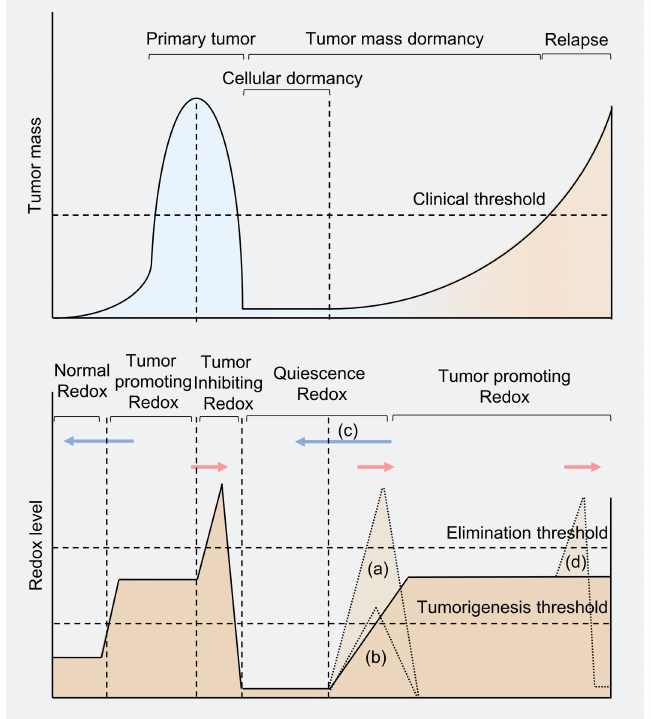
Figure 1. Model of tumor burden and redox level in cancer cell dormancy. Primary tumors rely on mild oxidative stress that increases ROS levels beyond the tumorigenesis threshold to proliferation. While under therapeutic conditions, the ROS level may be beyond the elimination threshold to rapidly decrease tumor mass. Several cancer cells (including residual cells and disseminated cells) may reprogram and survive in a redox level lower than normal cells and enter dormancy. When some dormant cancer cells awaken in the tumor population, the redox level may again exceed the tumorigenesis threshold. The tumor proliferates slowly under the clinical threshold, called tumor mass dormancy. Once the tumor mass exceeds the clinical threshold, the tumor has relapsed. Blue arrows represent potential strategies to conduct antioxidant therapy to treat tumors; red arrows represent potential oxidant-dependent therapy. ( a ) Strategy to kill dormant cancer cells through excessive ROS; ( b ) Strategy for reawaking dormant cancer cells to sensitize cancer cells to anti- proliferation drugs; ( c ) Strategy using antioxidant to keep dormant cancer cells from awaking; ( d ) Chemotherapy on recurrent tumors, but may enter into another life cycle of dormant cancer